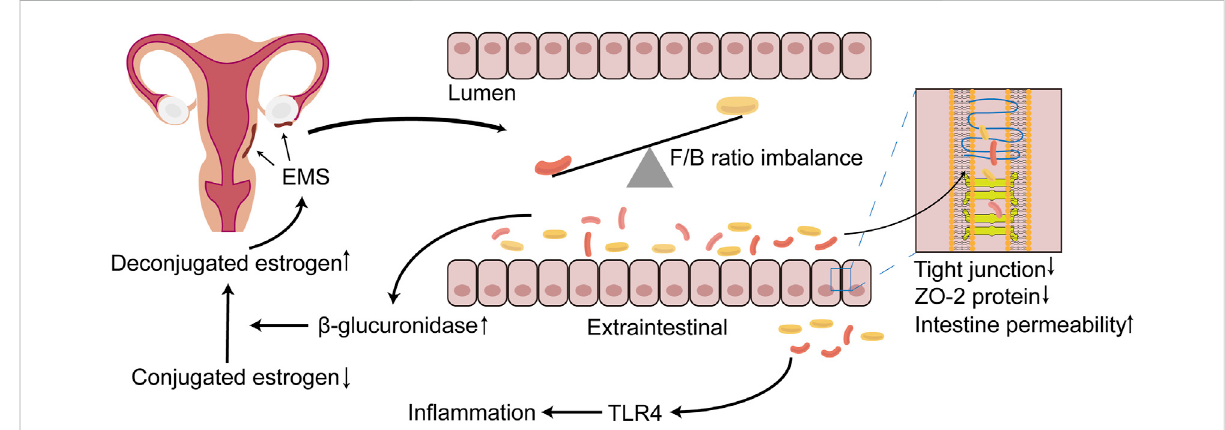
FIGURE 1 The relationshipbetweenEMS and GM imbalance. During theprogression ofEMS,which can occur theimbalanceof GM, the structure and the diversity of GM are altered, with the most dominant Firmicutes/Bacteroidetes (F/B) ratio being dysregulated. The disorder of GM results in the destruction of tight junction, the reduction of the expression of ZO-2 protein and further the increasing of the permeability of the intestine. Bacteria penetrate outside the intestinal lumen, activating TLR4, and lead to in fl ammatory responses, which may create a suitable environment for EMS onsetandprogression.Inaddition, β